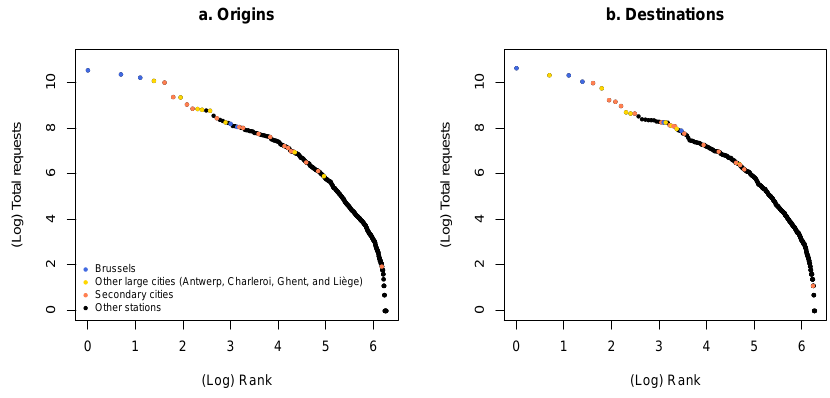
Figure 4. Rank - size distribution of the iRail requests. ( a ) Origins; ( b ) Destinations.